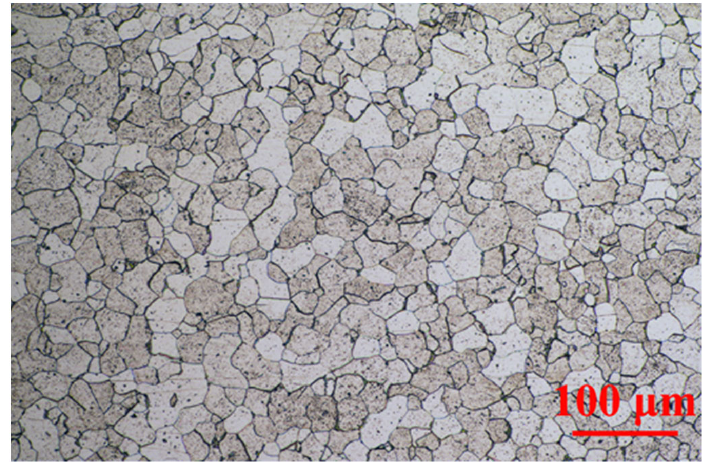
Figure 2. Metallographic diagrams of archaeological steel screw.